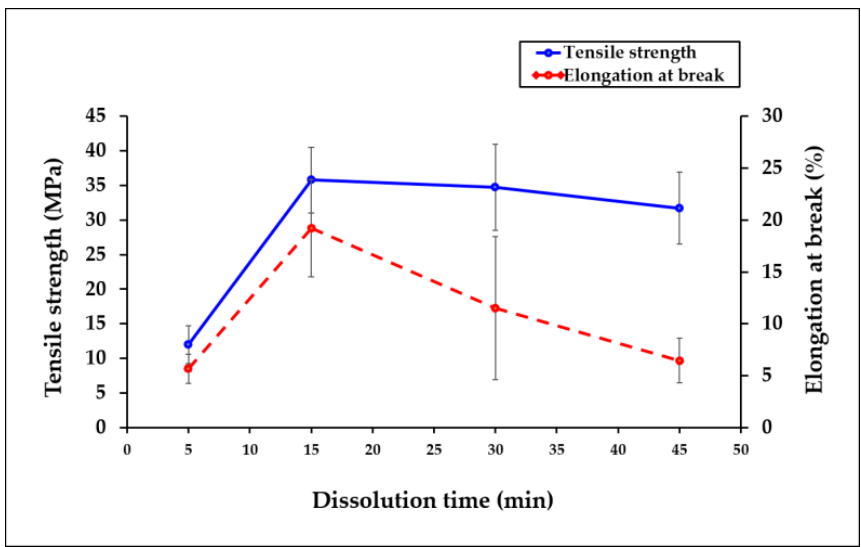
Figure 1. Mechanical properties of the ACC film composites made from OPEFB at dissolution times ranging from 5 to 45 min.